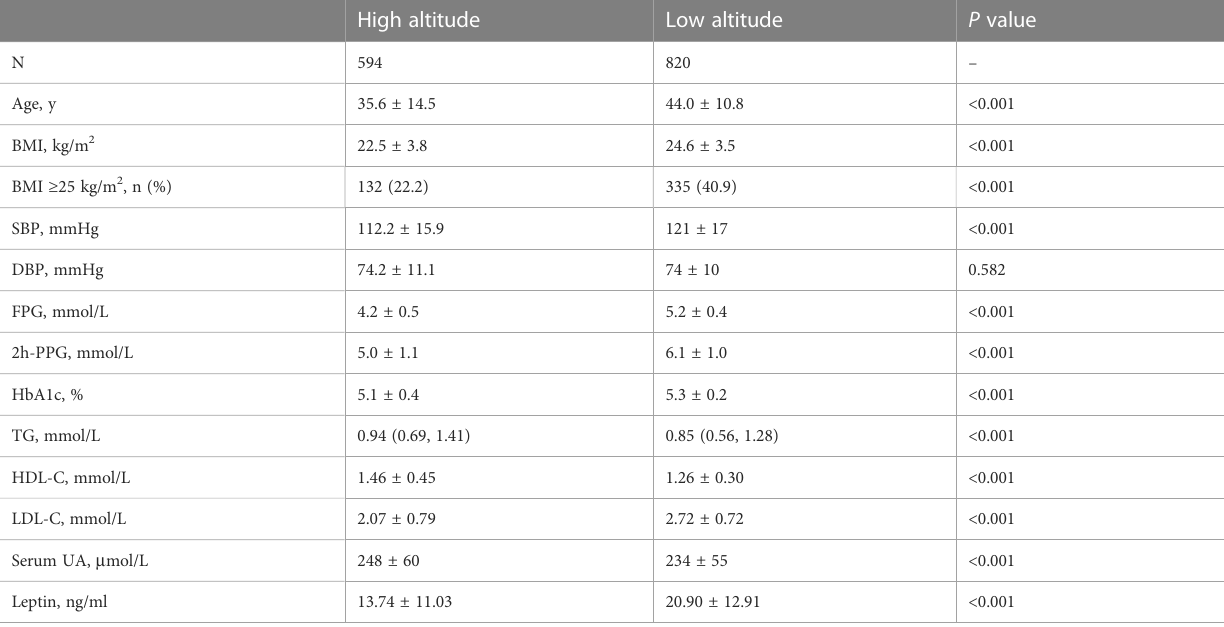
TABLE 1 The characteristics of native women living at high and low altitude.